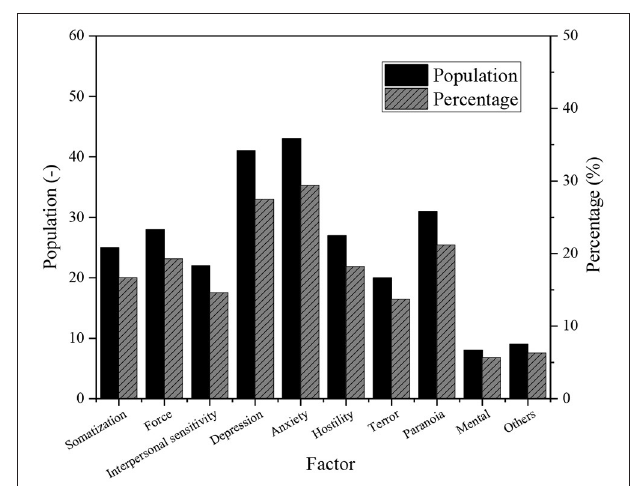
FIGURE 9 | Number of SCL-90 positive young